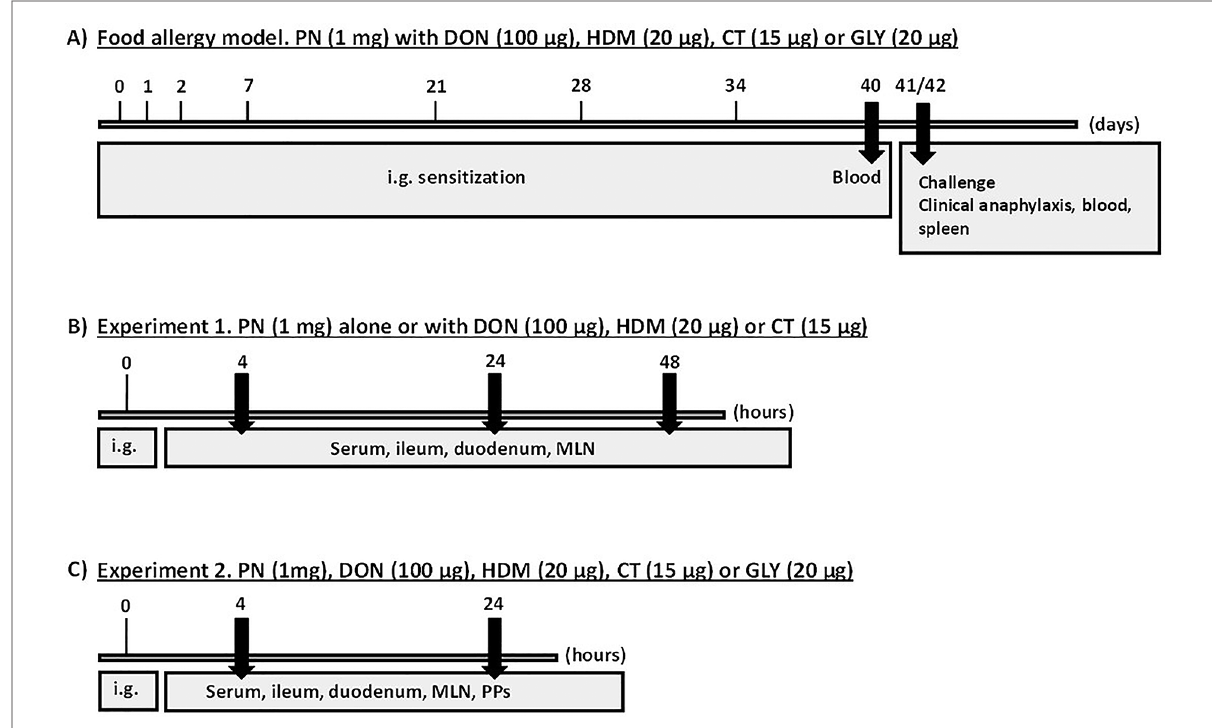
FIGURE 1 Experimental scheme. ( A ) Food allergy model. Mice were sensitized by repeated i.g. exposure to PN with a barrier disruptor up to 34 days and challenged with a high dose of PN given i.p. at day 41 or 42 to assess food allergy development. Clinical anaphylaxis was assessed, before collection of blood and spleen. ( B,C ) Short-term experiments. Mice were exposed once i.g. to a barrier disruptor with or without PN in experiments 1 and 2 to assess early effects. Blood and tissues were collected at 4, 24 and 48 ( B ) and 4 and 24 ( C ) hours after